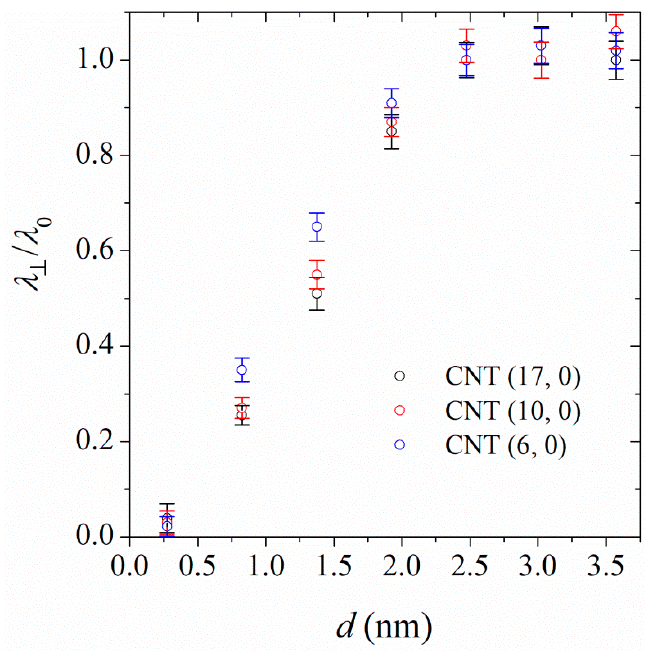
Figure 4. Dependence of perpendicular thermal conductivity, λ ⊥ , of PA-6,6 at the interface of CNT (17, 0), CNT (10, 0), and CNT (6, 0) at 350 K and 101.3 kPa. Here λ 0 is the thermal conductivity of the pure polymer, 0.27 W / (m · K). The values of λ ⊥ at d = 0.275 nm are the interfacial thermal conductivities.